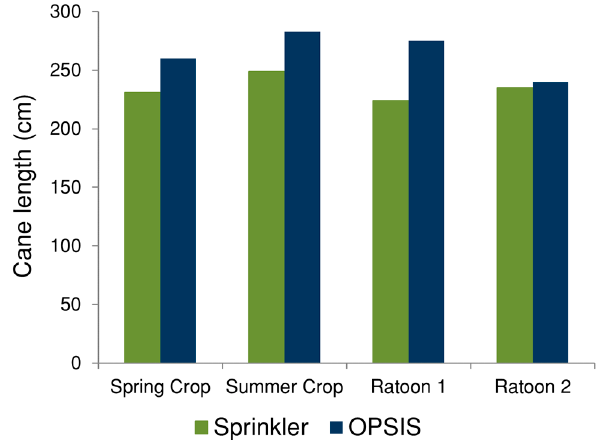
Figure 5. Average millable cane length of sugarcane cultivar Ni21 as affected by irrigation method.